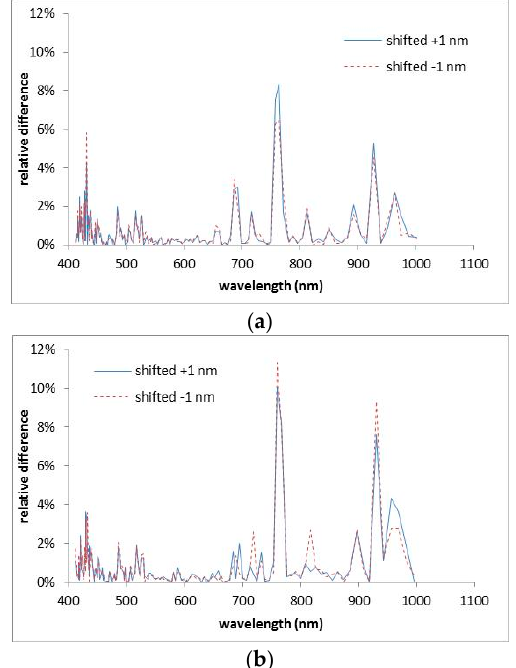
Figure 31. Calibration uncertainties caused by spectral shift of ±1 nm for SPARK-01 ( a ) and -02 ( b ).